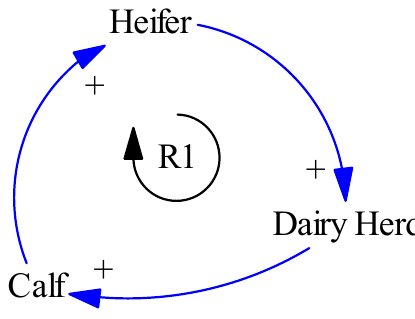
Figure 2. The ranch’s life loop.